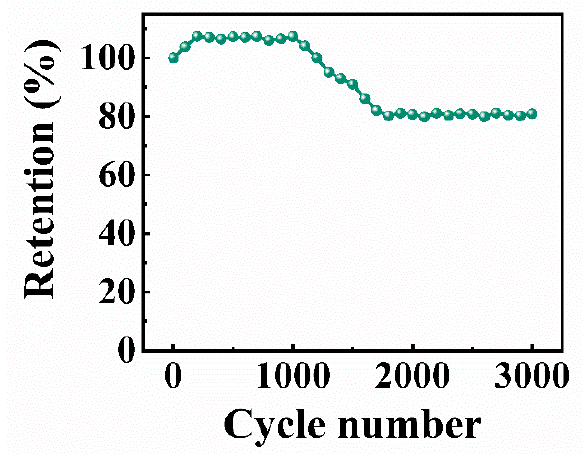
Figure 9. Capacitance retention for CFO-20 electrodes.